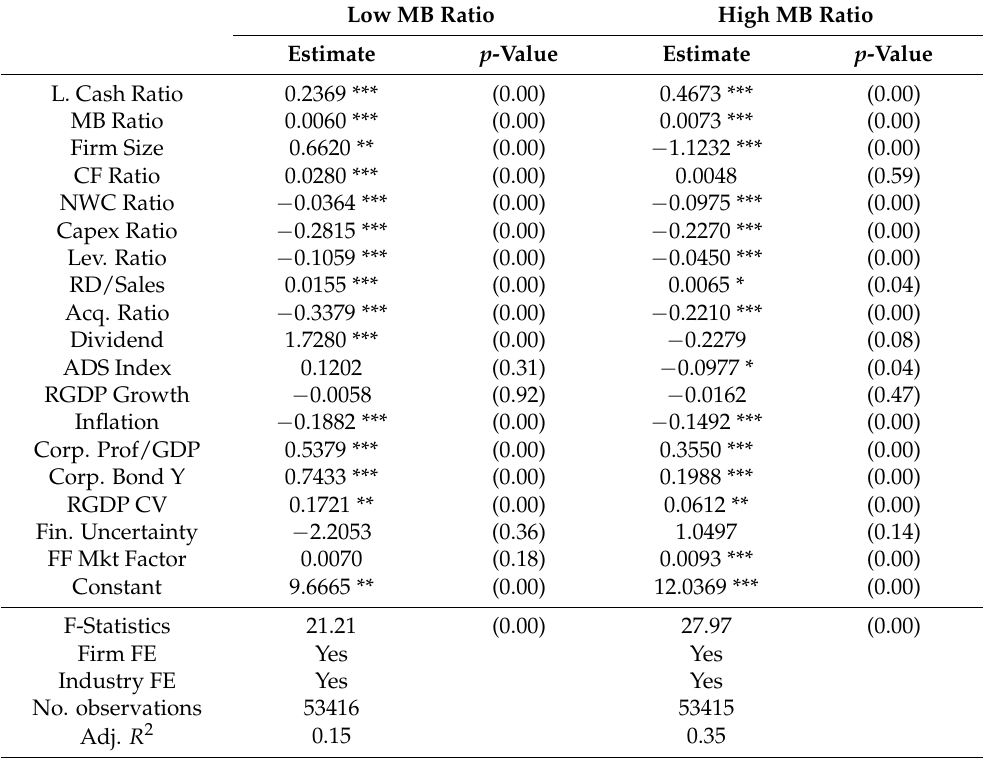
Table 6. Fixed-Effects Estimates by MB